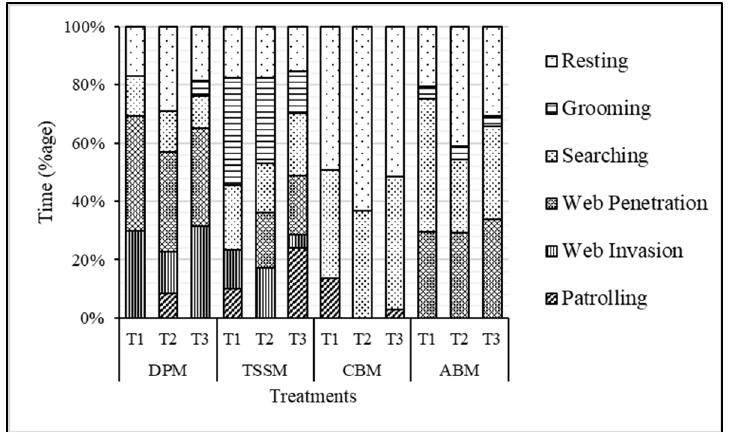
Figure 5. Percent time (min) spent in different behavioral categories by Stethorus gilvifrons against webbing of date palm mite (DPM) O. afrasiaticus , two-spotted spider mite (TSSM) T. urticae , citrus brown mite (CBM) E. orientalis and avocado brown mite (ABM) O. punicae . Table 2. Treatmentwise comparison of the time spent (mean ± std.dev) by the predator S . gilvifrons in six behavioral categories against four spider mite pest species (parentheses represent mean ± std.dev of untransformed time measurements). Patrolling Web Invasion Web Penetration Searching Grooming